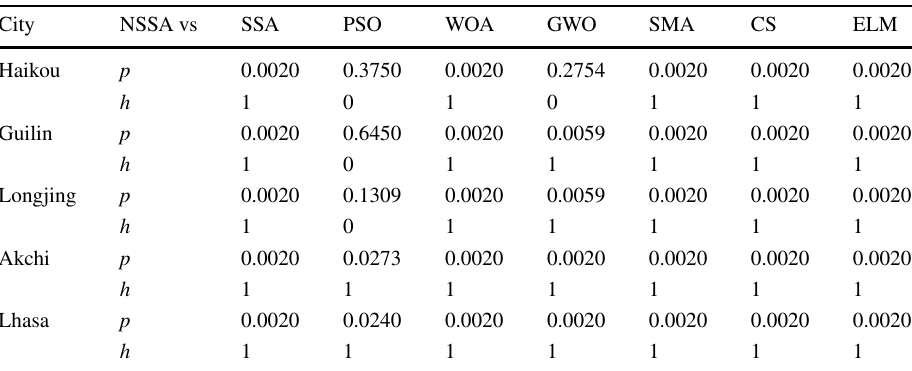
Table 7 p value and H value in Wilcoxon rank sum nonparametric